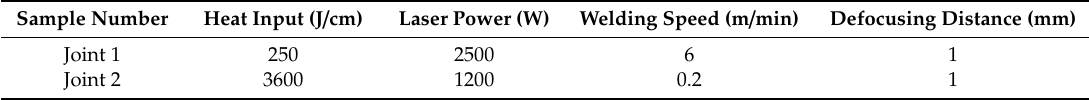
Figure 3. ( a ) Fiber laser welding system; ( b ) tooling and preheating device used in this study. Table 1. Laser welding parameters used for NS-Mo alloy.